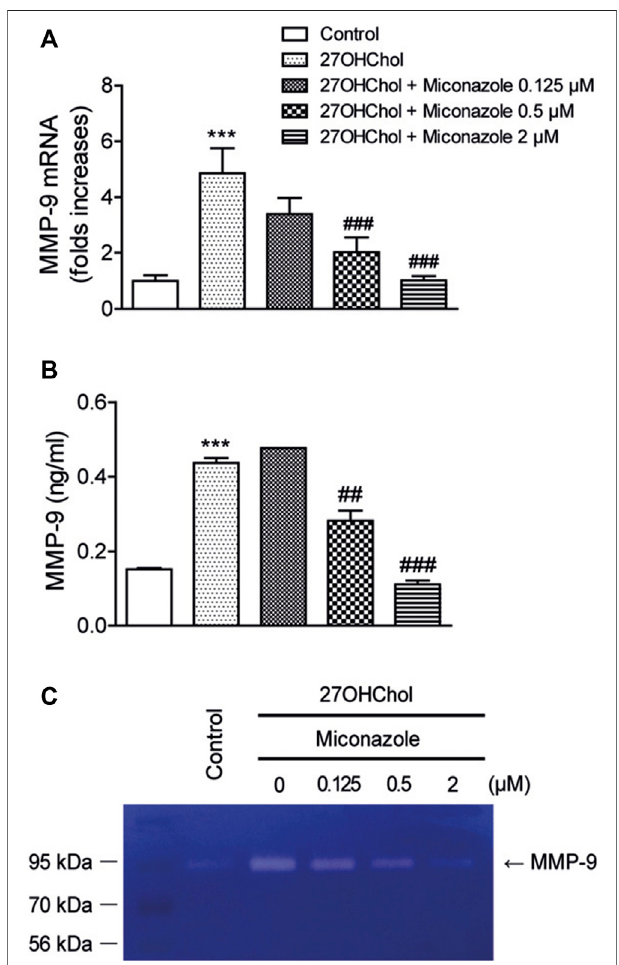
FIGURE 3 | Miconazole downregulates MMP-9 activity via transcriptional regulation. Serum-starved THP-1 cells were cultured for 48 h with 27OHChol in the presence of indicated miconazole concentrations. (A) MMP-9 transcript levels were assessed via quantitative reverse transcription-PCR, and (B) the amount of MMP-9 secreted into the medium was measured with ELISA. Results are representative of three independent experiments. Data are expressed as mean ± standard deviation (SD) ( n (cid:2) 3 replicates for each group). *** p < 0.001 vs control; ### p < 0.001 vs 27OHChol; ## p < 0.01 vs 27OHChol. (C) The activity of MMP-9 secreted by THP-1 cellswasassessed viagelatinzymography.Controlcellswerecultured for 48 h in medium alone. The image is representative of three independent experiments. 27OHChol, 27-hydroxycholesterol; MMP-9, matrix